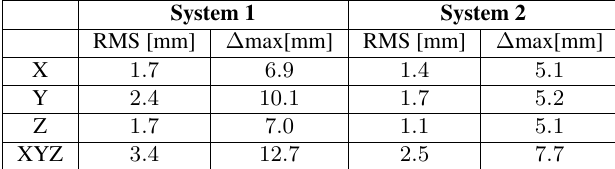
Table 3: Accuracies of the stereo